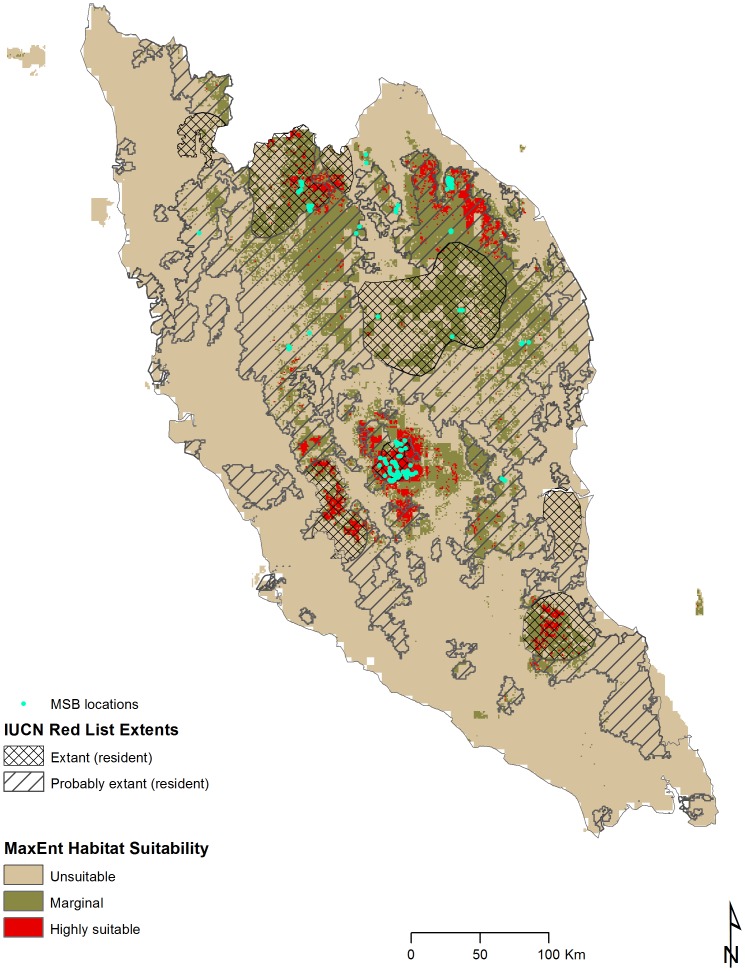
IUCN expert-based map showing extant and probably extant areas for MSB (Source: [25]).